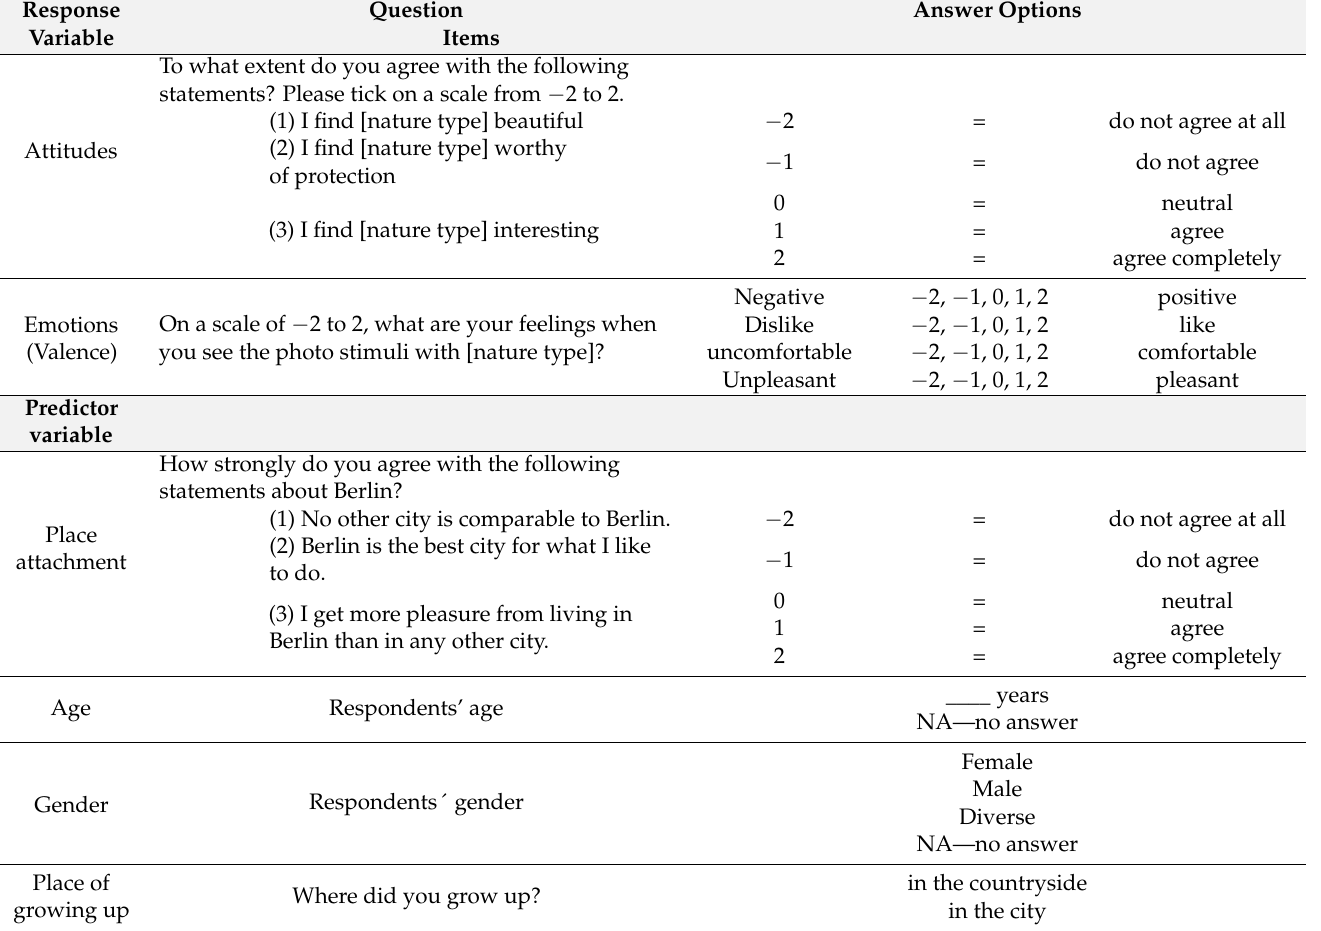
Table 2. Tabular summary of the response variables used in the questionnaire to query the attitudes and emotions towards the four nature types, as well as the related predictor variables, corresponding questions, items and scales used. The complete questionnaire in its original wording is listed in Appendix A (Table